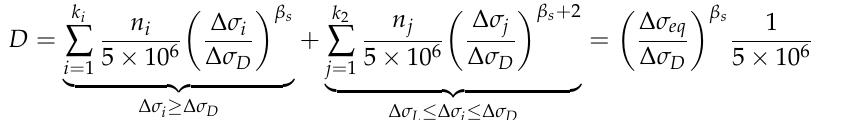
Figure 5. Time history of cable force for cable 1 and cable 28.